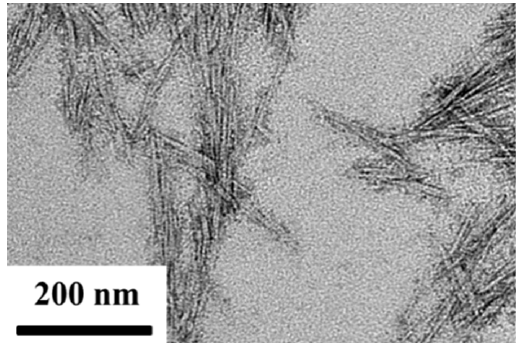
Figure 1. TEM image of synthesized cellulose nanocrystals.